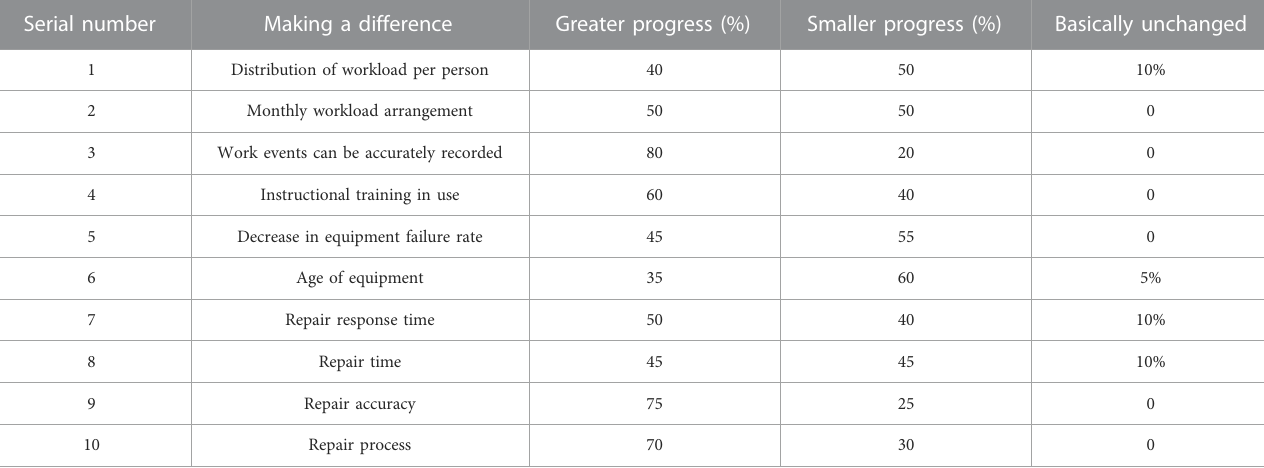
TABLE 3 Research data on medical equipment maintenance management platform for medical and nursing